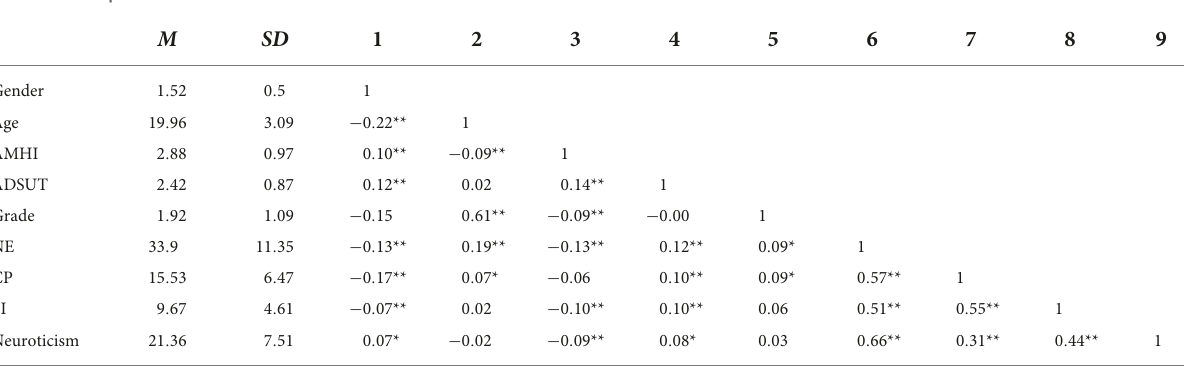
TABLE 1 Descriptive statistics and correlations for all variables.